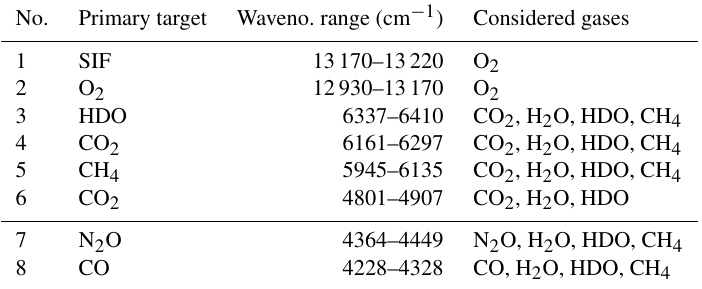
Table 4. Definition of GOSAT and GOSAT-2 spectral fit windows (same for S and P). Windows 7 and 8 are only available for GOSAT-2.